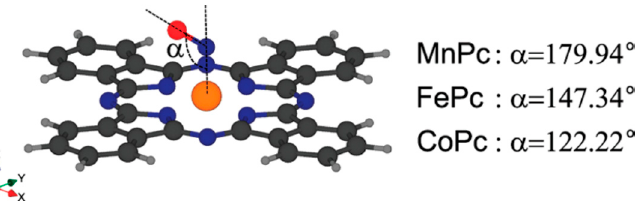
Figure 3. The most stable configurations for NO adsorbed on MPc after full optimization. Reprinted with permission from [69] Copyright 2010, American Chemical Society.